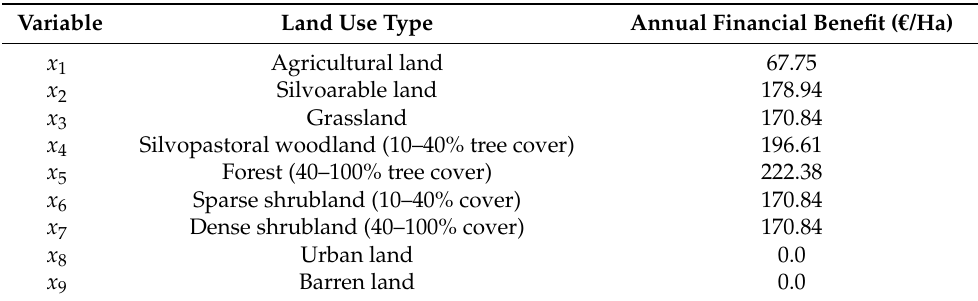
Table 5. Value (EUR/Ha) of ecosystem services by land use category in the area of the Municipality of Mouzaki, adapted from Constanza et al.